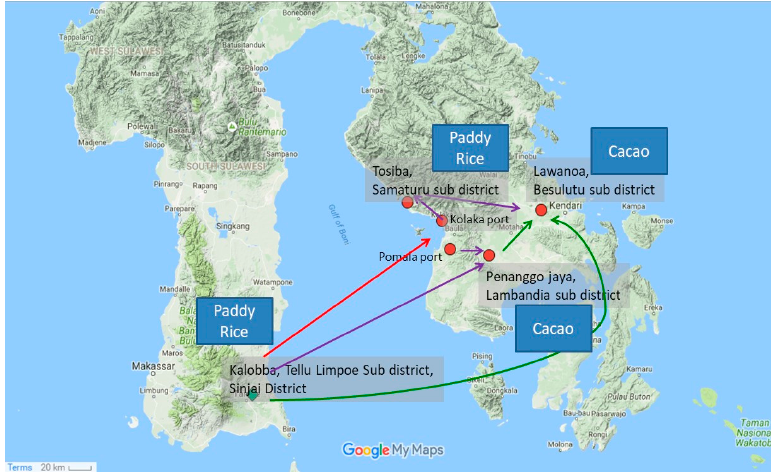
Figure 2. The source and destination of migrants in our first case study, in South (left) and Southeast Sulawesi (right), respectively.